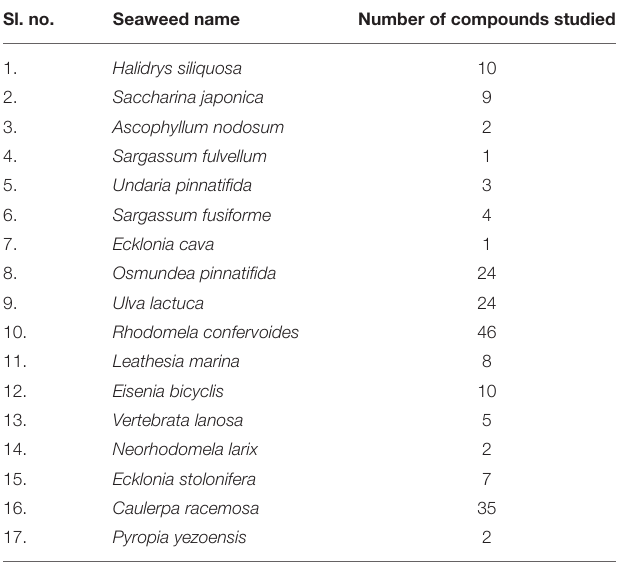
TABLE 1 | List of edible seaweed studied for identification of prospective HDAC 2 inhibitors to combat cancer. Sl.